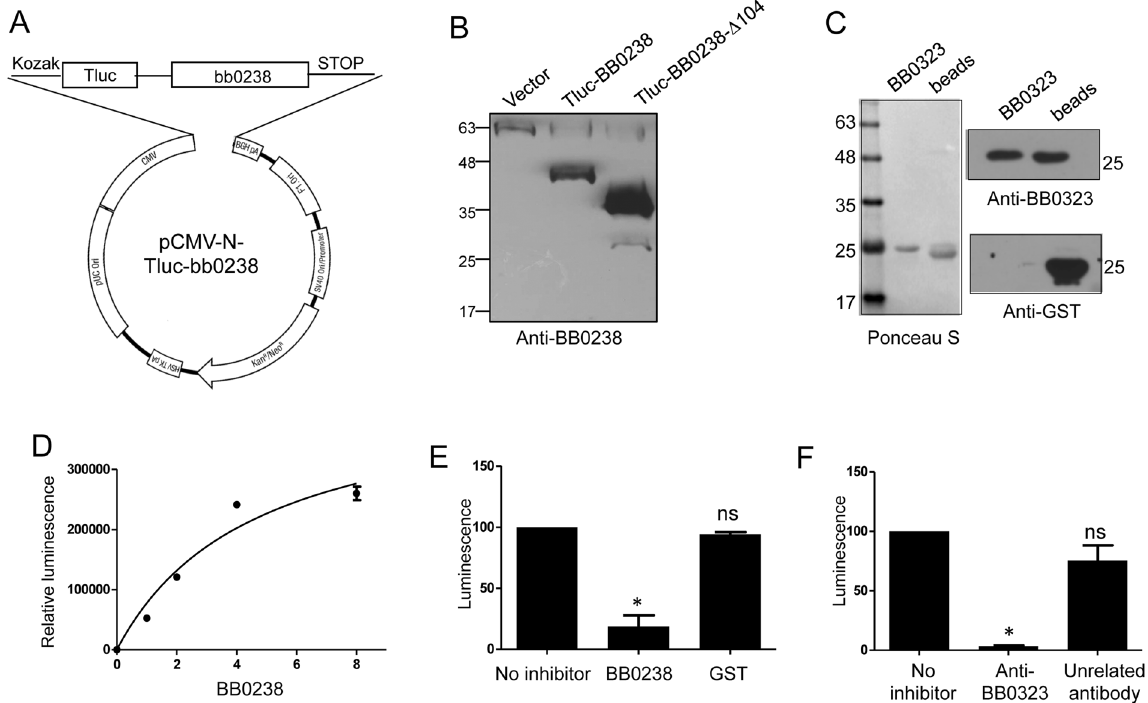
Figure 6. Development of a high throughput screening- compatible and luciferase based assay to monitor BB0238-BB0323 interaction. ( A ) Vector map of pCMV N-Tluc-bb0238 for the expression of BB0238 fused to TurboLuc (Tluc) Luciferase. The cytomegalovirus (CMV) promoter allows strong expression of TurboLuc-BB0238. ( B ) Production of BB0238 or derivatives in transfected mammalian cells. Immunoblot analyses of 293 T cells transfected either with empty vector (lane 1), or luciferase fused BB0238 (full length or truncated BB0238- ∆ 104, lanes 2 and 3) probed with BB0238 specific antisera. ( C ) Purification of BB0323. BB0323-N-terminus (residues 22–225) was cleaved from GST using PreScission protease and the supernatant fraction carrying purified BB0323 and post cleavage beads were probed with anti-BB0323 and anti-GST antibody to rule out GST contamination in BB0323. ( D ) BB0238 binding to BB0323 measured by a luciferase assay. A 96-well white opaque plate was coated with BB0323 (0.1 µ g/well), blocked with 5% BSA and incubated with increasing amount of lysates expressing BB0238 in fusion with luciferase (Tluc-BB0238). After washing, bound proteins were detected using luciferase substrate solution and the relative luminescence unit was measured using a luminometer. Binding was calculated after subtracting the blank (wells incubated with increasing amount of extracts transformed with empty vector) mean ± standard error of the mean. (E and F). Competition of BB0238-BB0323 binding. The binding of Tluc-BB0238 with immobilized BB0323 was determined in the presence of recombinant BB0238 purified from E . coli ( * p < 0.05, ns - non significant) ( E ) or antibody specific to BB0323 ( * p < 0.01). ( F ). The luciferase activity in the absence of any competitor was considered as 100%, and the results are expressed as the percentage of Tluc-BB0238 bound to BB0323. One- or two-tailed Student’s t tests were used to compare the mean values using GraphPad